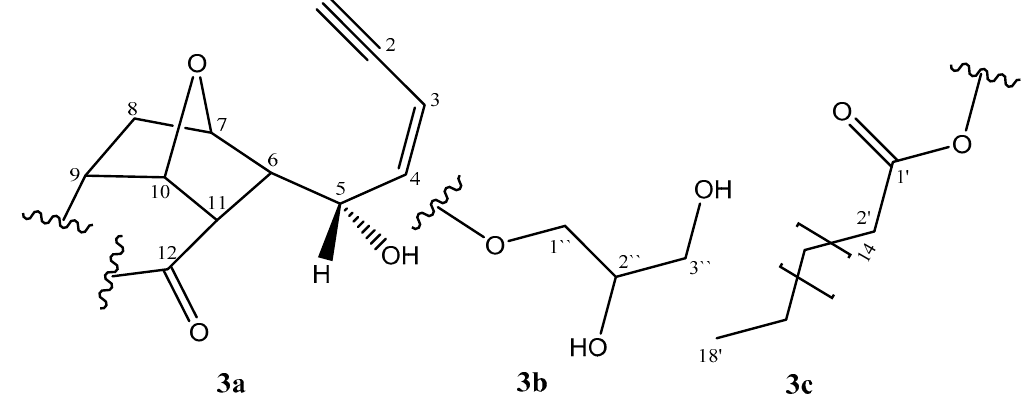
Figure 3. Substructures of compound 3.